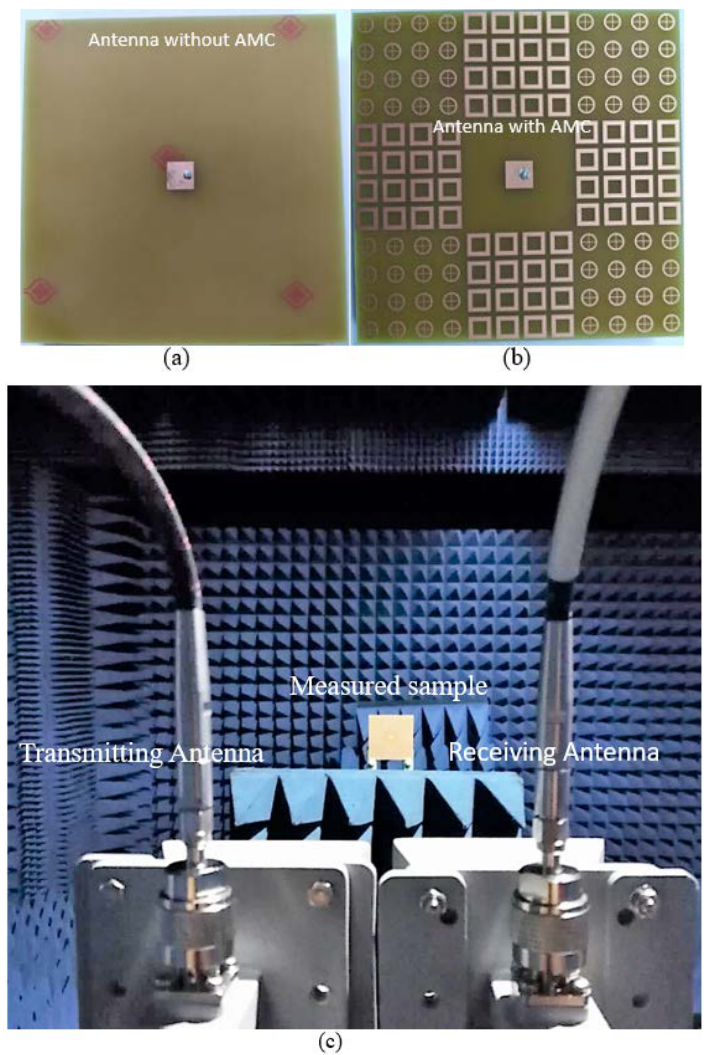
Figure 12. Prototypes of proposed antenna. ( a ) Fabricated reference antenna. ( b ) Fabricated proposed prototype. ( c ) The proposed prototype in a microwave chamber for measurements.